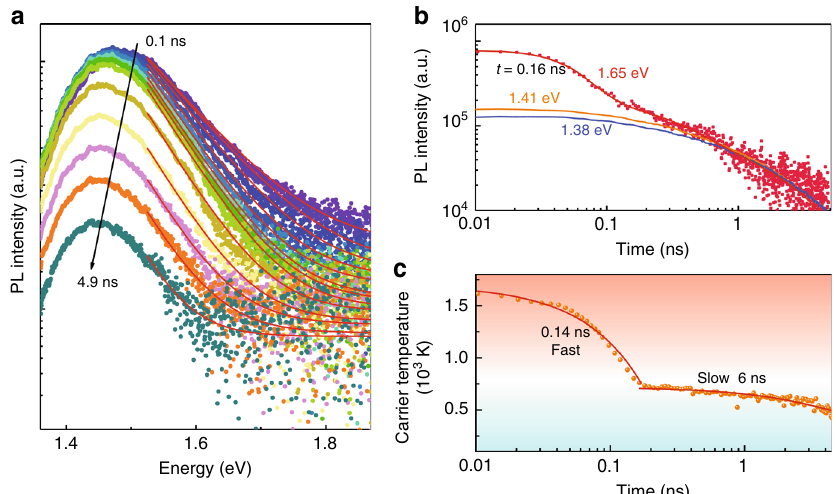
Fig. 4 Photoluminescence from FASnI 3 thin fi lm with addition of SnF 2 . a Semi-log plot of PL spectra at different delay time after excitation under an excitation fl uence of 28 μ Jcm − 2 . The high-energy tail of the PL spectra is fi tted with I PL / α ð E Þ exp (cid:2) hv = kT c ð Þ , where T c is the carrier temperature, and h ν is photon energy. b PL intensity decay at 1.65, 1.41, and 1.38 eV. The PL intensity has been normalized at the tail. c Extracted carrier temperature from the hot- carrier distribution as a function of the delay time. The fast component is fi tted to be 0.14 ns, and the slow component is around 6 ns. The carrier temperature is obtained by fi tting the high-energy tail of the PL spectra at each delay time (Supplementary Note IV)